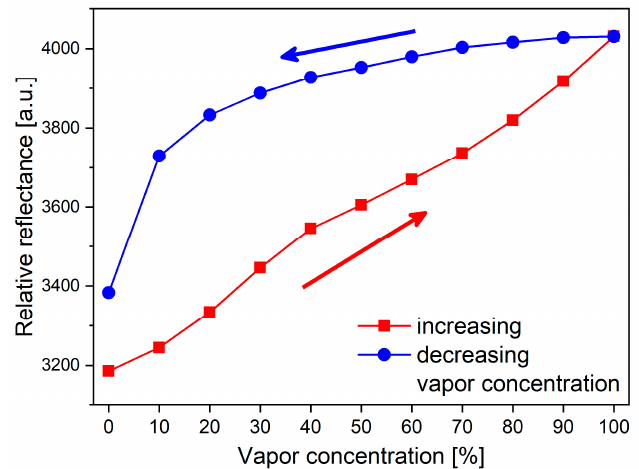
Figure 1. Peak intensity of the relative reflectance spectrum of a Polyommatus icarus specimen during increasing/decreasing ethanol vapor concentration. The graph showing hysteresis suggests that capillary condensation of the vapors is the governing process during the color change of the butterfly wings.